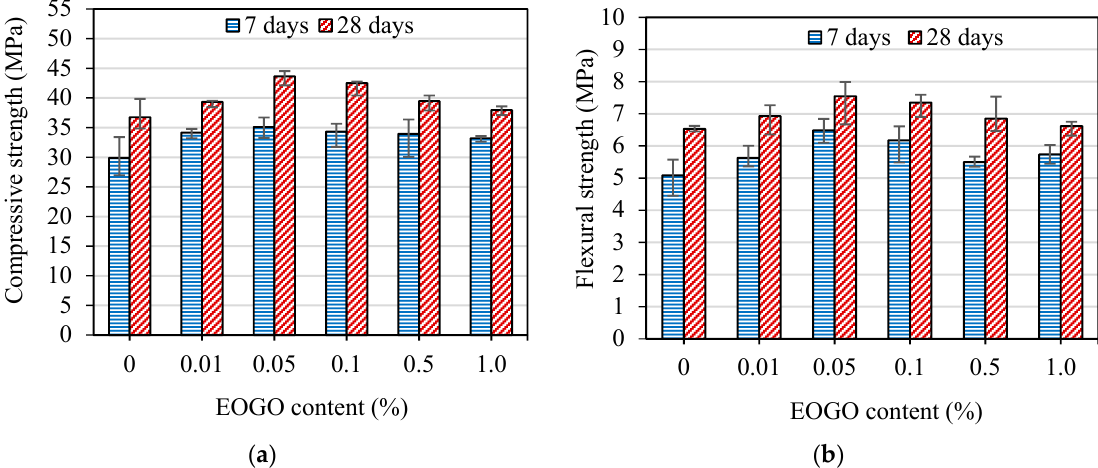
Figure 7. ( a ) Compressive strength and ( b ) flexural strength of EOGO-mortars with the dry-mix design method.